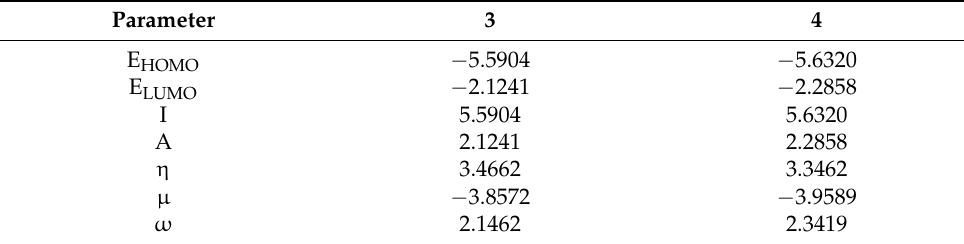
Table 7. Reactivity parameters of the studied